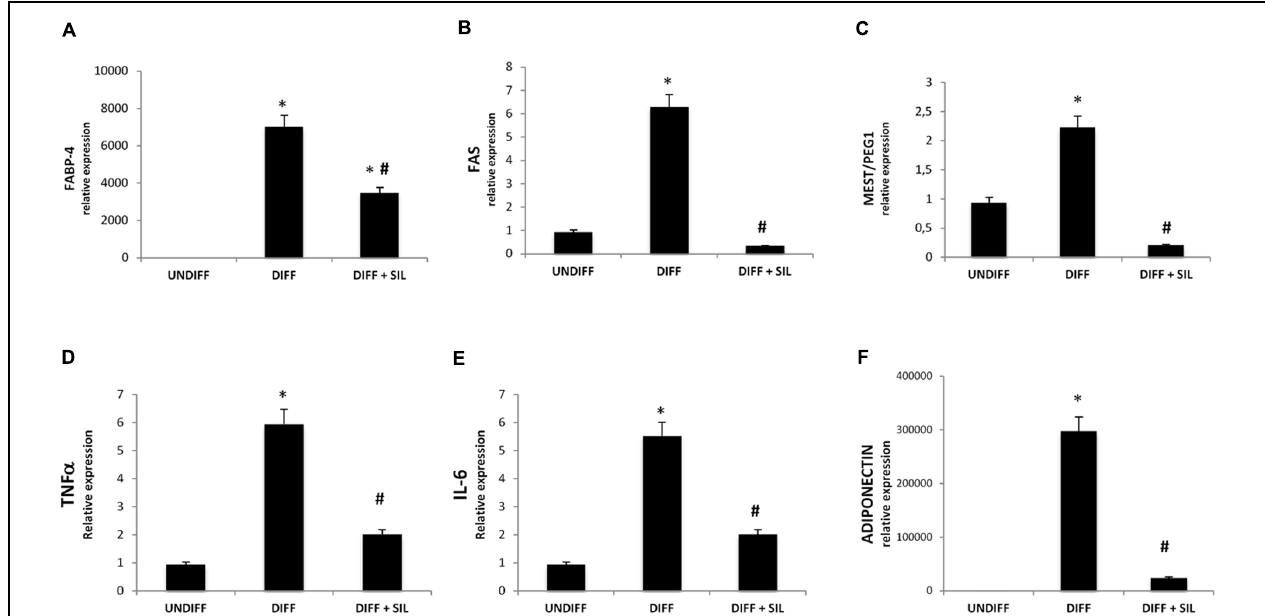
FIGURE 2 | Analysis of gene expression by Real time PCR of FABP4 (A), FAS (B), MEST/PEG1 (C), TNF α (D), IL-6 (E), and adiponectin (F). All values are expressed as mean ± SEM of four experiments ( n = 4) in duplicate. ∗ P < 0.05 vs. undifferentiated; # P < 0.05 vs. differentiated.